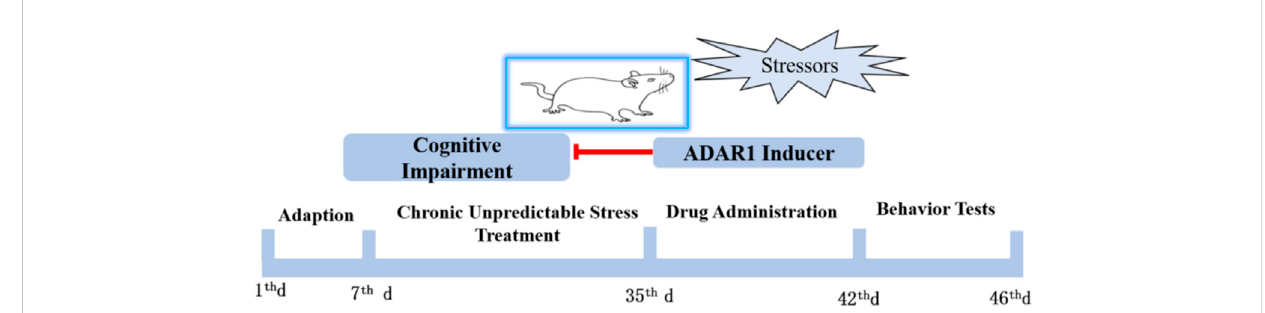
FIGURE 1 Schedule of the protocol in the experiments in vivo . Male BALB/mice were adapted to the standard environment for 1 W. Chronic unpredictable stressors were given to the mice of the model group and drug intervention model group from the 7th day to 35th day. The drug administration was intraperitoneally injected for 1 W. ADARl inducer or ADARl inhibitor was given to the mice of the model group and drug-treated only group. The mice in thecontrol group and modelgroup wereintraperitoneally injected with vehicleconsecutively.Behavior tests, includingnew object recognition and new object localization tests, were used to detect the cognitive function of the